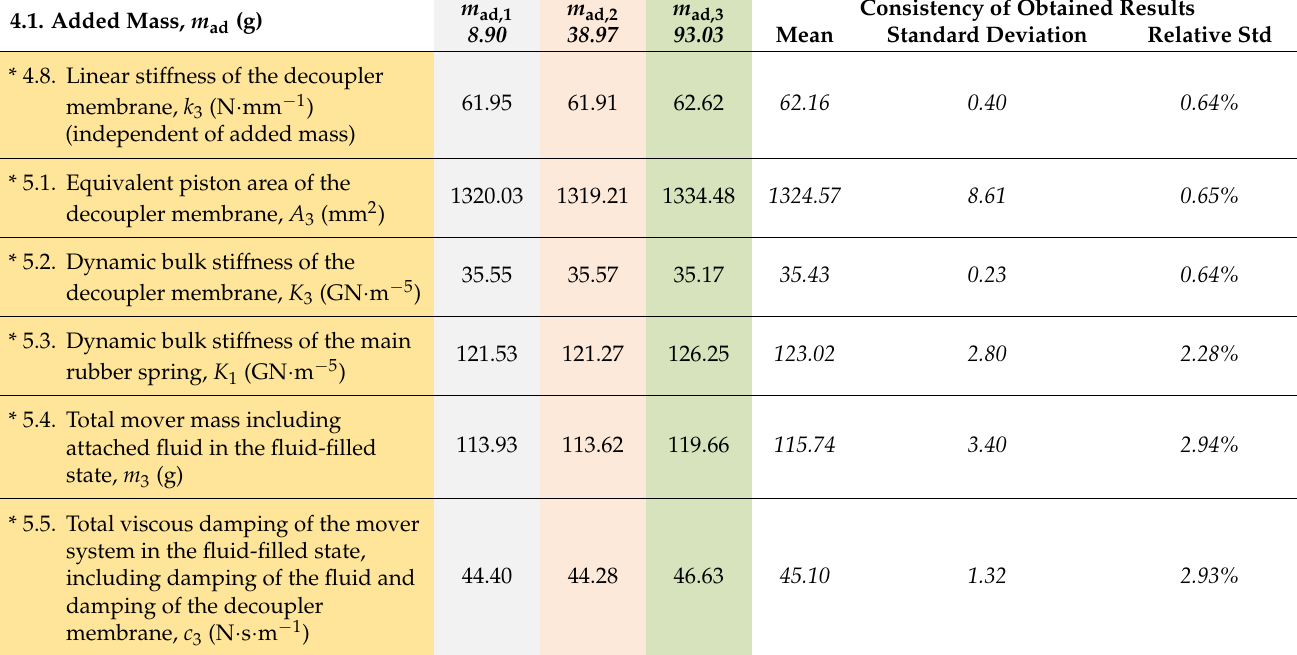
Table 2. Consistency check of identified parameters for an